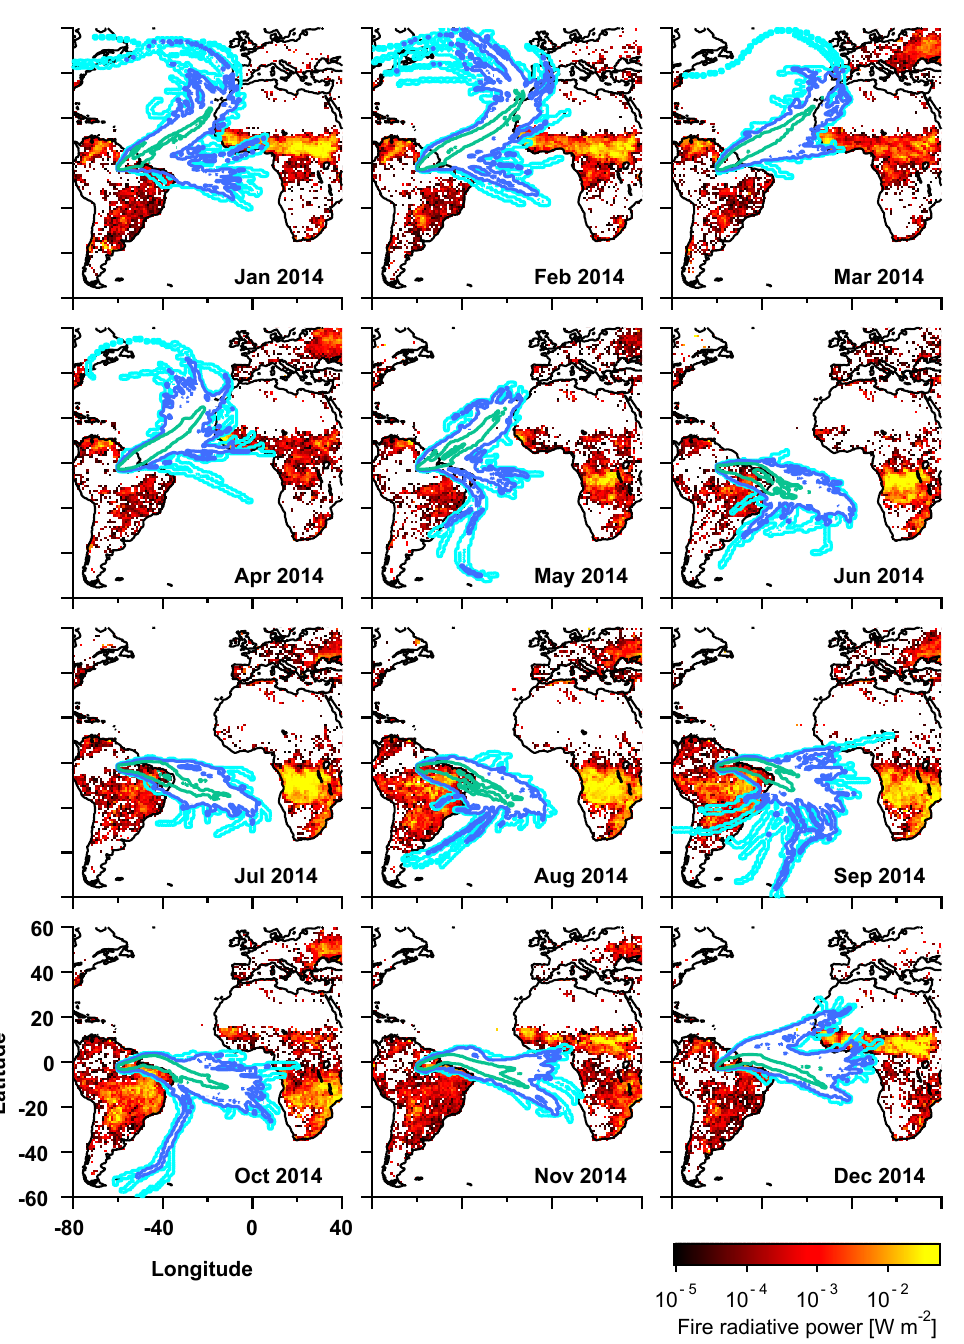
Figure 3. Back trajectory frequency plots and satellite fire maps for the ATTO site in 2014. Back trajectories (9 days) have been calculated with HYSPLIT (NOAA-ARL, GDAS1, start height 1000m) (Draxler and Rolph, 2015). Four back trajectories have been initiated per day (0:00, 06:00, 12:00, 18:00 UTC); frequency plots are based on monthly trajectory ensembles. Color coding of frequency plots: > 10% (green), > 1% (blue), > 0.1% (cyan). Monthly fire map derived from GFAS (Global Fire Assimilation System) and averaged to 1 ◦ grid resolution (Kaiser et al.,